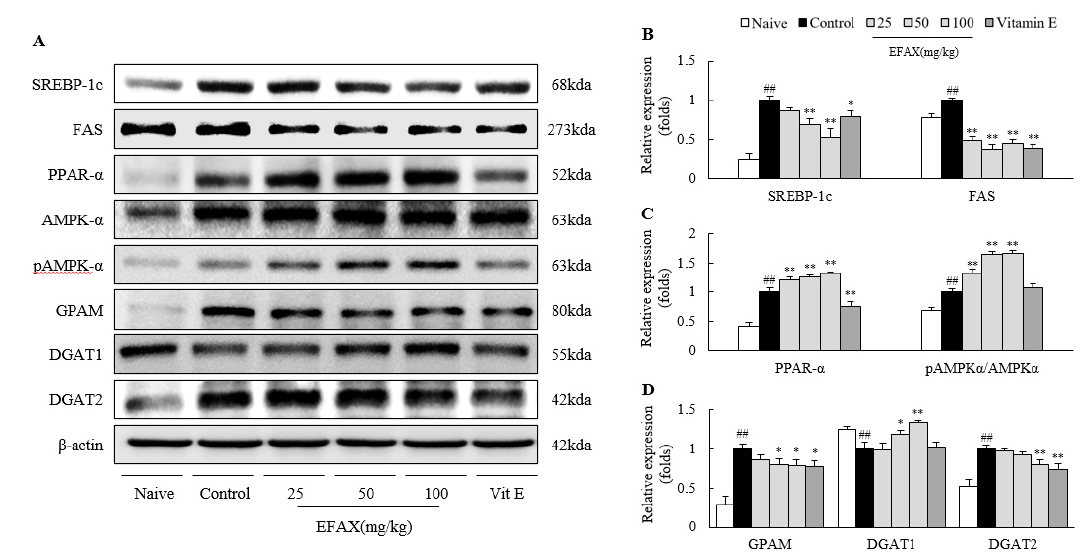
Figure 3. Effects on hepatic levels of lipid metabolic proteins. Mice ( n = 8 in each group) were fed a 60% high-fat diet for 8 weeks, excluding the naive group (normal chow diet). From the 3rd week of high-fat diet feeding, distilled water (control), EFAX (25 mg/kg, 50 mg/kg, 100 mg/kg), and vitamin E (100 mg/kg) were administered by gavage daily for the last 6 weeks. Western blot analysis evaluated the hepatic level of eight-lipid metabolic proteins ( A ), and semi-quantifications were performed on sterol regulatory element-binding protein (mSREBP)-1c and fatty acid synthase (FAS) ( B ); peroxisome proliferator-activated receptor (PPAR)- α , AMP-activated protein kinase (AMPK)- α , and phosphorylated-AMPK (pAMPK)- α ( C ); and glycerol-3-phosphate acyltransferase (GPAM), diglyceride acyltransferase (DGAT)1, and DGAT2 ( D ). ## p < 0.01 compared with the naive group; ∗ p < 0.05, ∗∗ p < 0.01 compared with the control group.